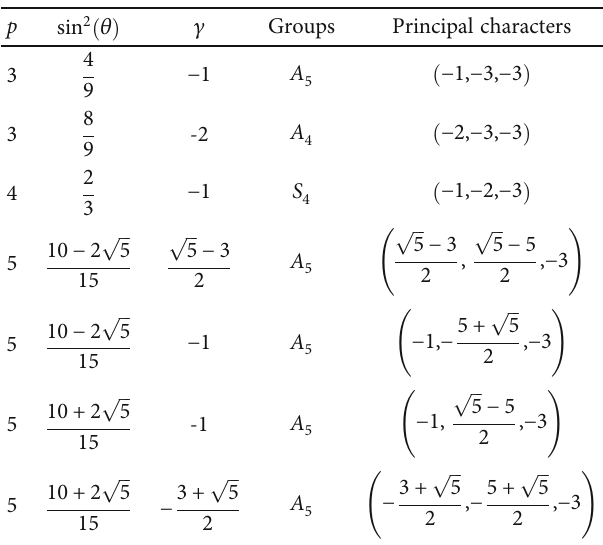
Table 2: Principal Characters: 3, p .